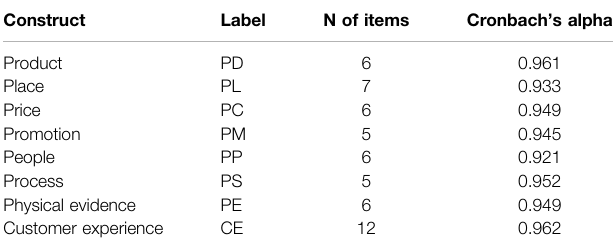
TABLE 7 | Internal consistency of the customer questionnaire. Construct